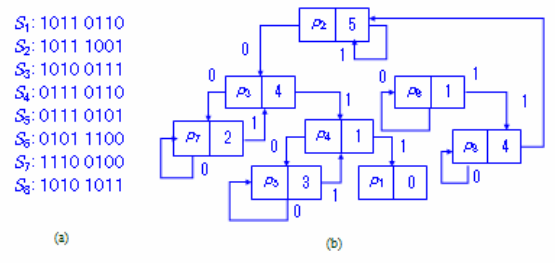
Figure 6. Signature file and signature graph